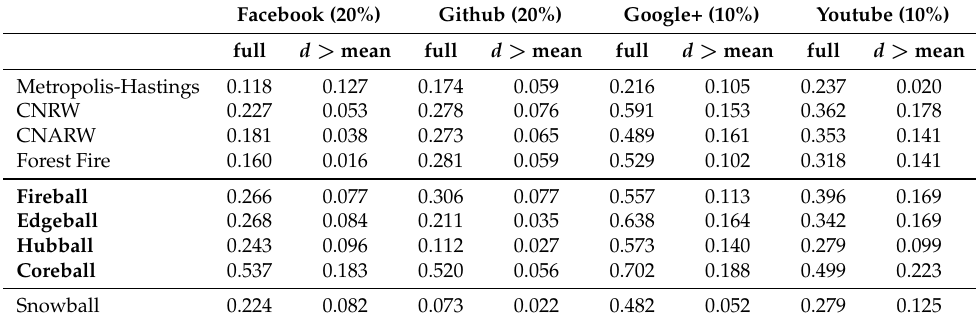
Table 2. Kolmogorov-Smirnov test for degree distribution similarity (lower is closer) for the Facebook and Github graphs sampled at 20%, Google+ and Youtube graphs sampled at 10%. The degree distribution is considered either fully (“full” column) or for high-degree (greater than the mean degree of all nodes in the graph) nodes only.